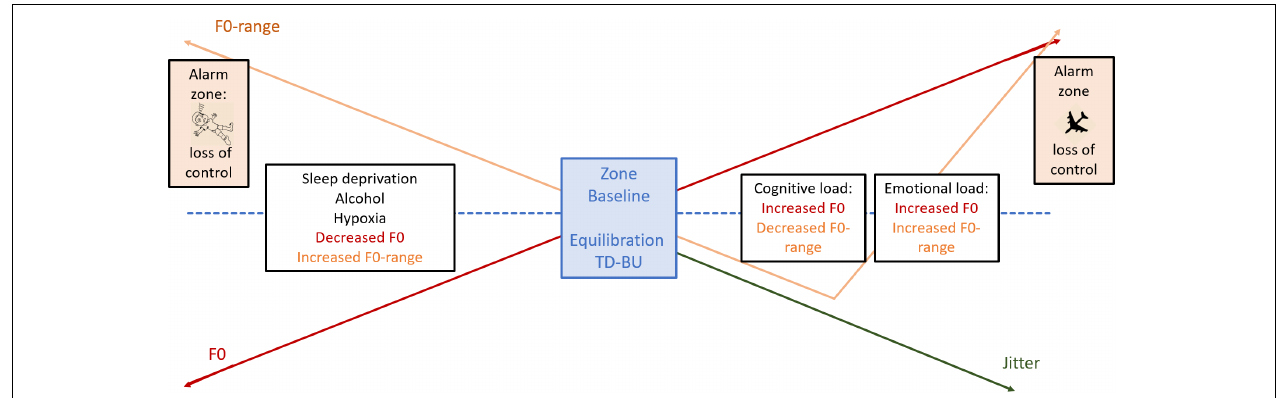
FIGURE 2 | “Model for Voice and Effort” (MoVE). The MoVE shows how the activity of ongoing top-down (TD on the Figure) and bottom-up (BU on the Figure) processes are mirrored within the phonation voice parameters F0, F0-range and jitter. Increased F0-ranges correspond with reduced top-down processes reaching an alarm zone when cognitive top-down control is lost—such as in life-threatening emergency situations (e.g., flight crash, alcohol intoxication). Decreased F0-ranges are consequential of high cognitive load and top-down control. The additional information of mean F0 values gives insight in the bottom-up arousal activity and the effort a subject is capable to generate. Highly increased or decreased F0-values are indicative of effort-depletion, also reaching an alarm-zone in life-threatening emergency situations (e.g., flight crash, alcohol intoxication). Jitter expresses bottom-up arousal in an inverse manner. Cognitive and emotional load correspond with respective small and larger reduced jitter